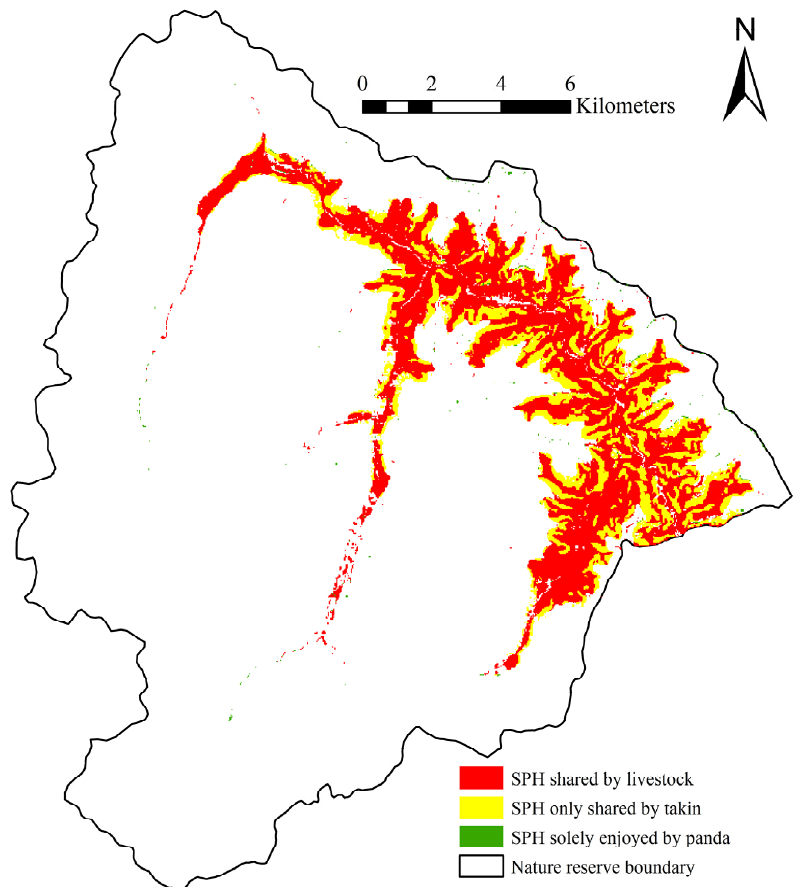
Figure 5. Suitable giant panda habitat shared by livestock and takin (SPH: suitable giant panda habitat).